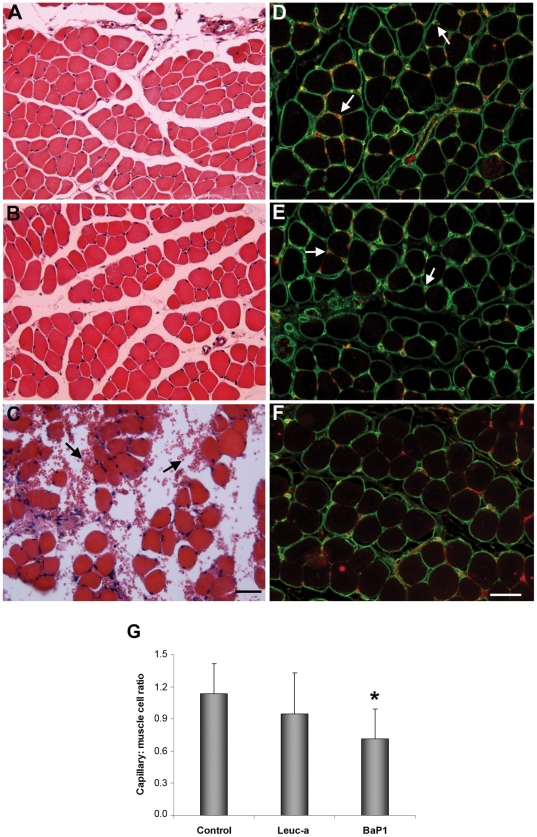
Histological and immunohistochemical analysis of the effects of BaP1 and leuc-a in skeletal muscle.Mice were injected with either 50 µL PBS as control (A, D), 50 µg of leuc-a (B, E) or 50 µg BaP1 (C, F). Tissue samples were collected 15 min after injection and processed for embedding in paraffin (see experimental details in Methods). A, B and C: Hematoxylin-eosin staining. Hemorrhage, evidenced by the presence of erythrocytes in the interstitial space (arrows), occurred only in muscle injected with BaP1. D, E and F: Immunostaining with anti-type IV collagen (green) and anti-VEGFR2 (red). Arrows depict capillary vessels. There is a reduction in capillary vessels positive for type IV collagen and VEGFR2 in samples treated with BaP1, whereas no reduction in the staining of capillaries was observed in tissue injected with leuc-a. Bar corresponds to 50 µm. (G) The total number of capillaries and muscle cells were counted in various sections, and the capillary: muscle cell ratio was calculated. Results are presented as mean ± SD. A significant reduction in the ratio was observed only in muscle injected with BaP1, but not with leuc-a. *P<0.05 when compared with capillary: muscle cell ratios of control and leuc-a-treated samples.